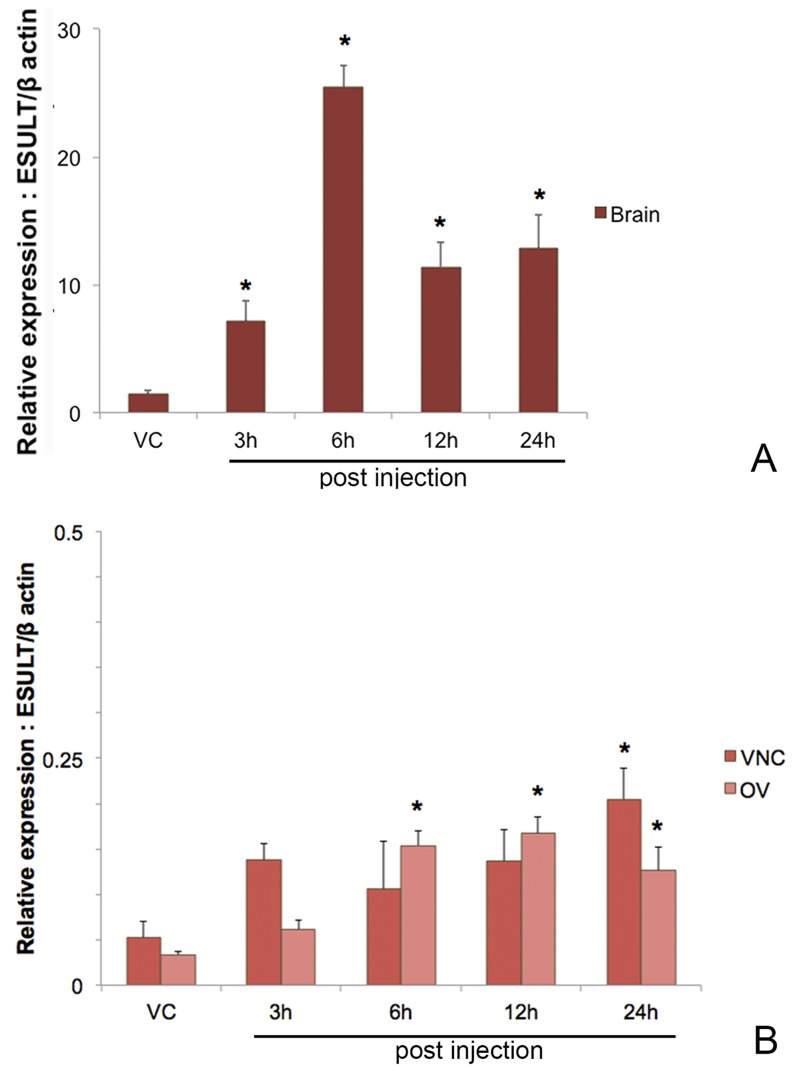
Effect of priming 5-HT on the relative ESULT gene expression levels of S. olivacea using quantitative RT-PCR.(A) ESULT mRNA expression levels in the brain (n = 12) were determined at 3, 6, 12 and 24 h post 5-HT injection. (B) ESULT mRNA expression levels in the VNC and ovary (n = 12) were determined at 3, 6, 12 and 24 h post 5-HT injection. Data were normalized against β-actin. Asterisks indicate significant differences (p<0.05) with respect to the control (vehicle-injected) group. Abbreviations: estrogen sulfotransferase (ESULT), and vehicle control (VC).